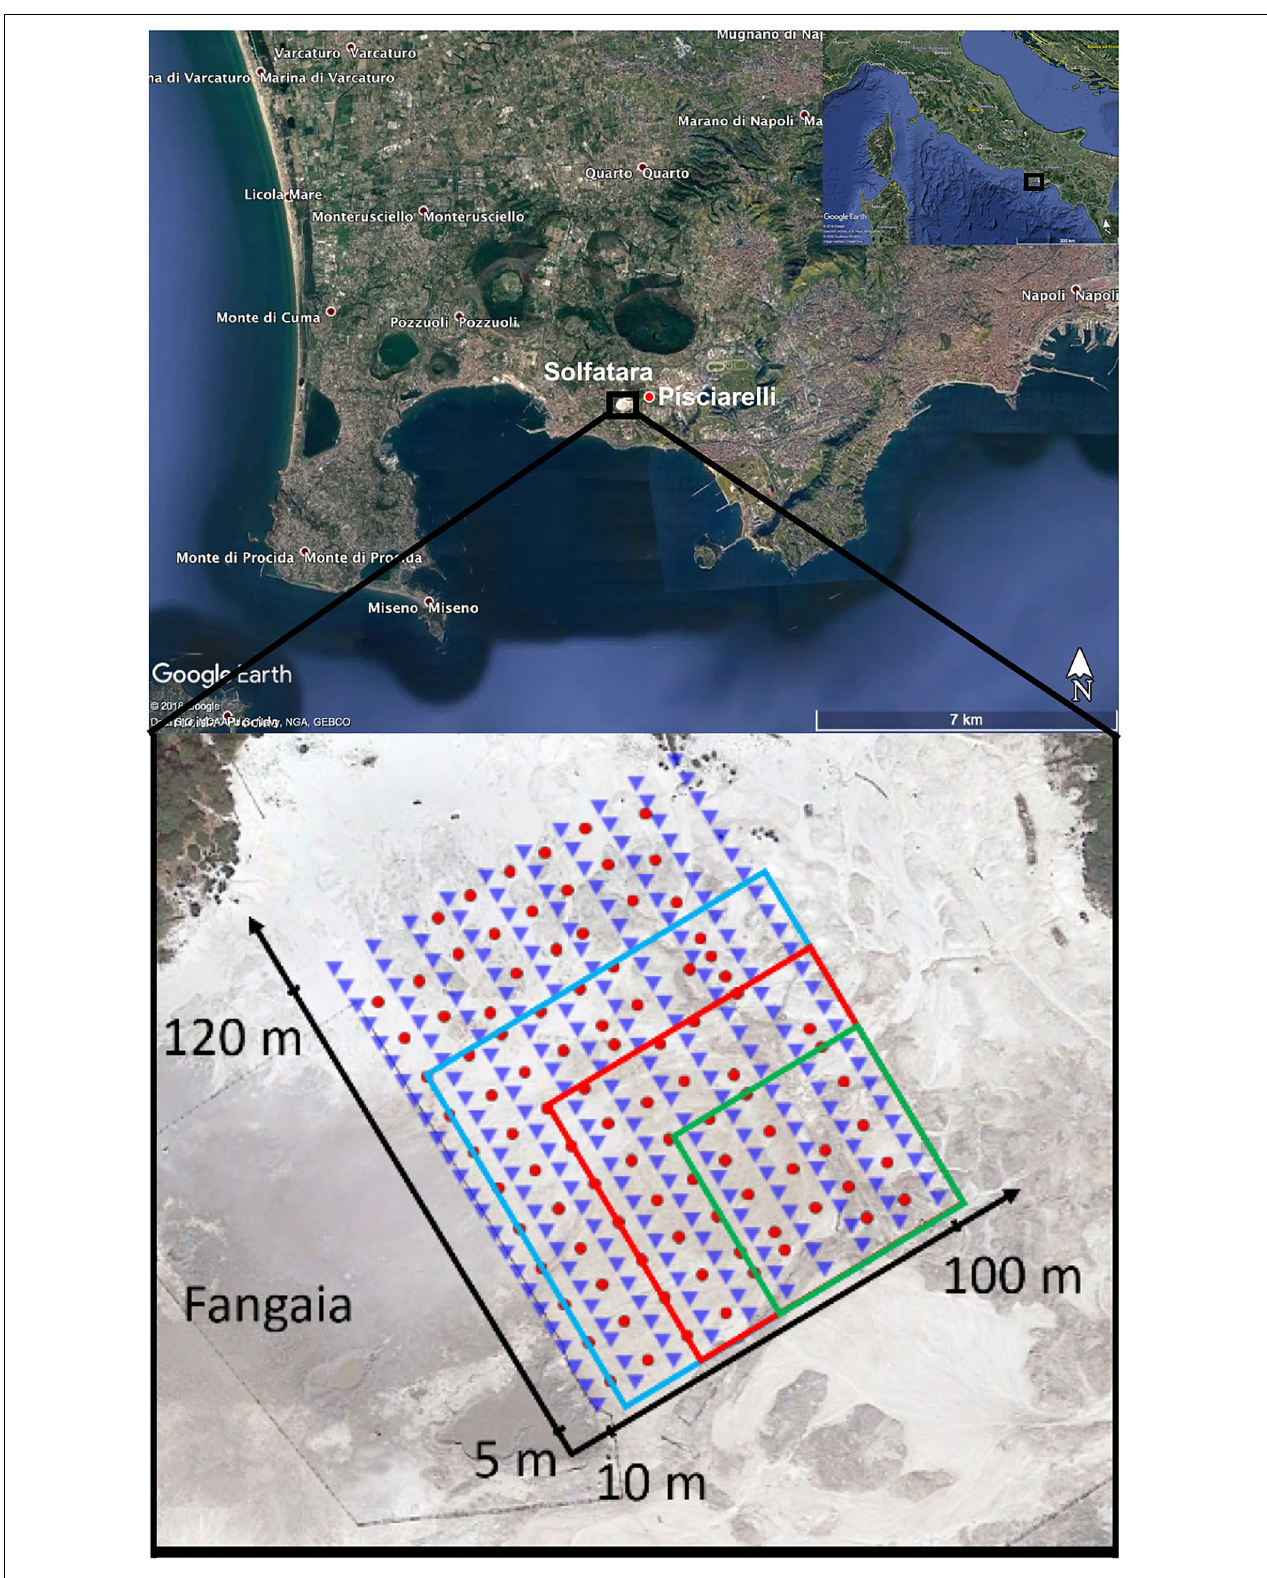
FIGURE 1 | Location of the Solfatara volcano where the experiment has been performed. In the inset the experimental setup, with stations (blue triangles) and shots (red circles) positions. The green, red, and cyan squares represent the subgrids used to evaluate the scattering mean free path l s .